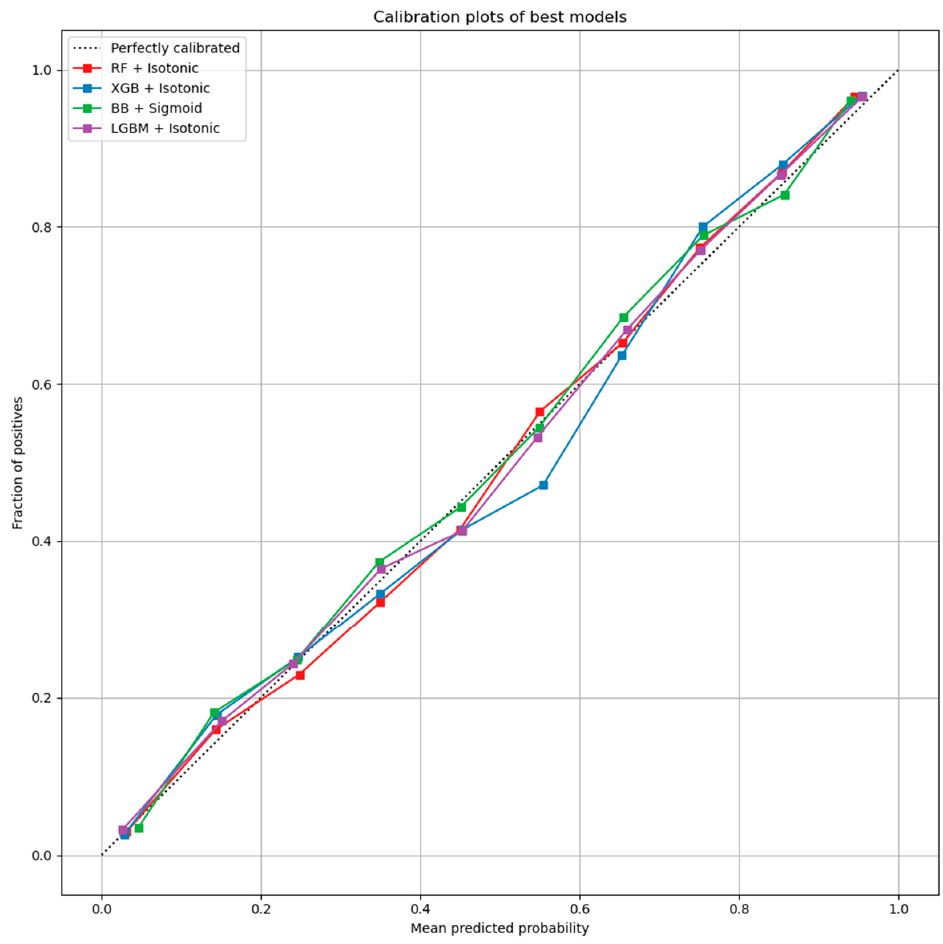
Figure 4. Best calibrated models for each classifier.